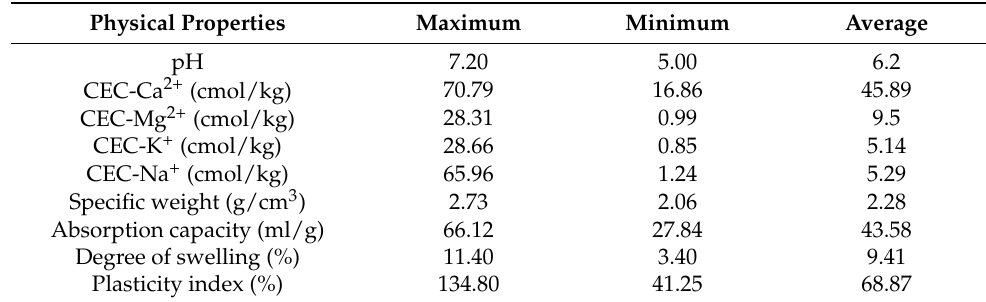
Table 8. Physical properties of the studied bentonites and bentonitized rocks. Physical